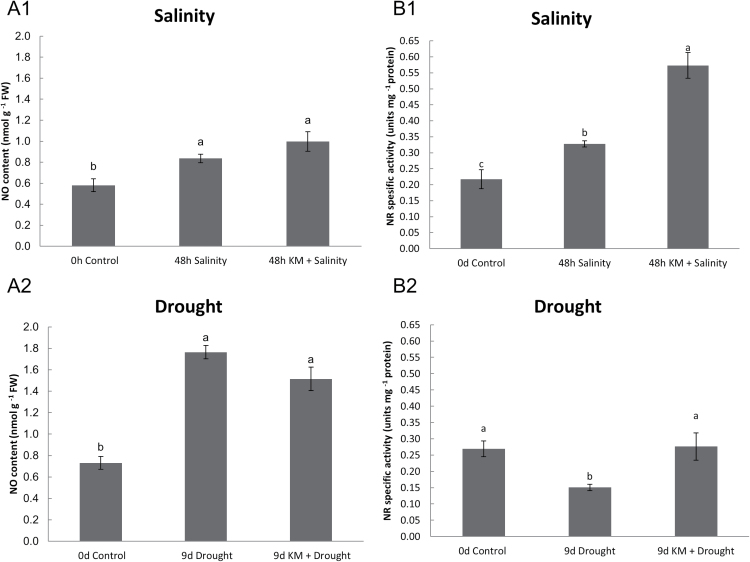
(A) Nitric oxide content and (B) nitrate reductase (NR) activity in salinity-stressed (A1, B1) and drought‐stressed (A2, B2) M. truncatula plants in the absence or presence of KM pre-treatment (KM 10–8 M).